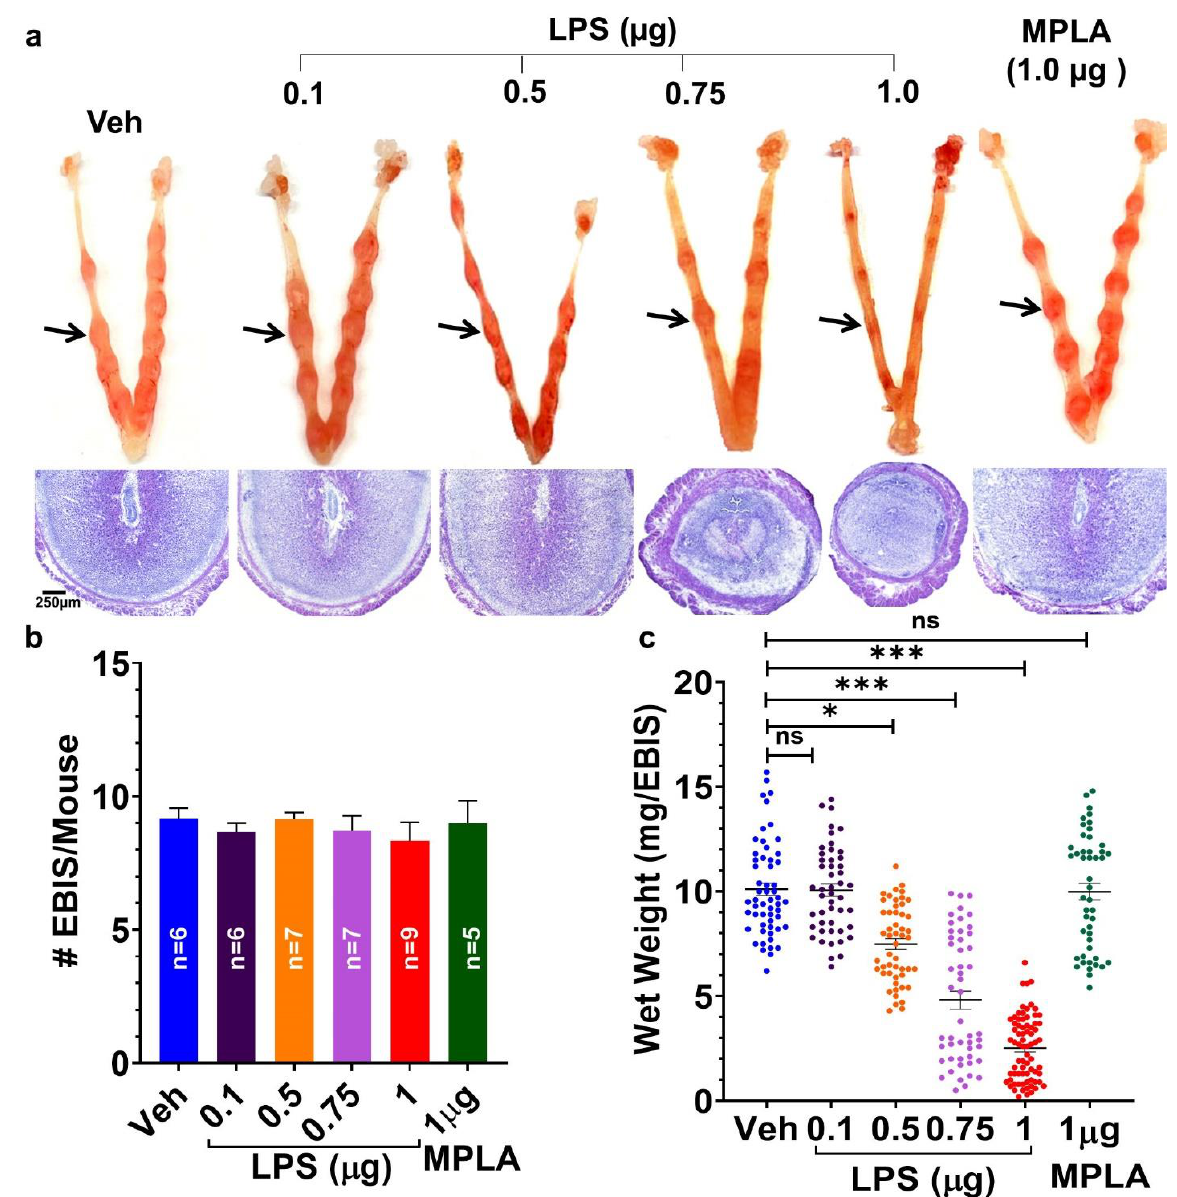
Figure 6. Systemic lipopolysaccharide (LPS) exposure induced dose-dependent defects at the EBIS. All pregnant mice except the vehicle (saline) and monophosphoryl lipid A (MPLA) controls received an injection (i.p.) of LPS on day 5 of pregnancy and their pregnancy outcomes were analyzed on day 7. ( a ) Visible structural appearances of EBISs (top row) and their histopathology (H&E staining, bottom row) determined the dose-dependent effects of LPS exposure on EBISs. Arrows indicate blastocyst implantation sites; ( b ) Number of EBISs (number (n) of mice used in each treatment group was indicated within the bar); ( c ) Wet weight of individual EBIS. Results are presented as mean ±SEM. * p < 0.05, *** p < 0.001 (ANOVA followed by Tukey test). Veh, vehicle; EBIS, early blastocyst implantation site; ns, not significant.